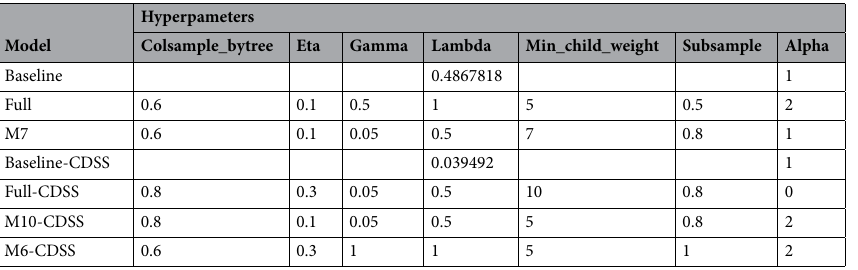
Table 2. Hyperparameter tuning of predictive models. The Baseline models used LASSO regression while the rest used the XGBoost. For the latter, the number of estimators was 1000 and the maximum depth of each tree was set to